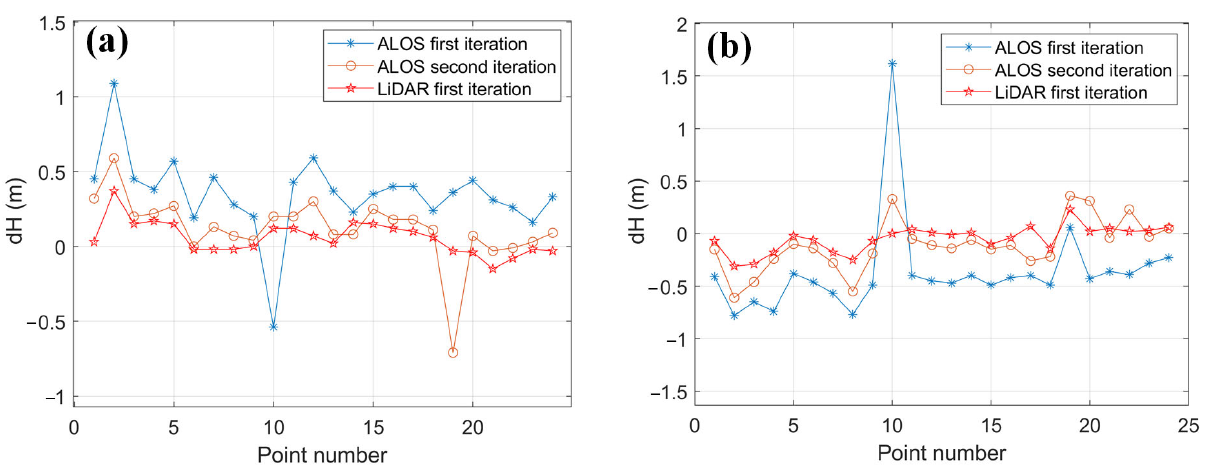
Figure 11. Comparison chart of the elevation accuracy of the GF ‐ 7 laser after calibration based on Figure 10. Comparison chart of the elevation accuracy of the GF-7 laser after calibration based on AW3D30 and LiDAR. ( a ) The beam 1 result of the GF ‐ 7 laser. ( b ) The beam 2 result of the GF ‐ 7 laser. AW3D30 and LiDAR. ( a ) The beam 1 result of the GF-7 laser. ( b ) The beam 2 result of the GF-7 laser. The results in Figure 10 show that when higher-precision reference terrain data are used for calibration, the elevation accuracy of the GF-7 satellite laser can be further